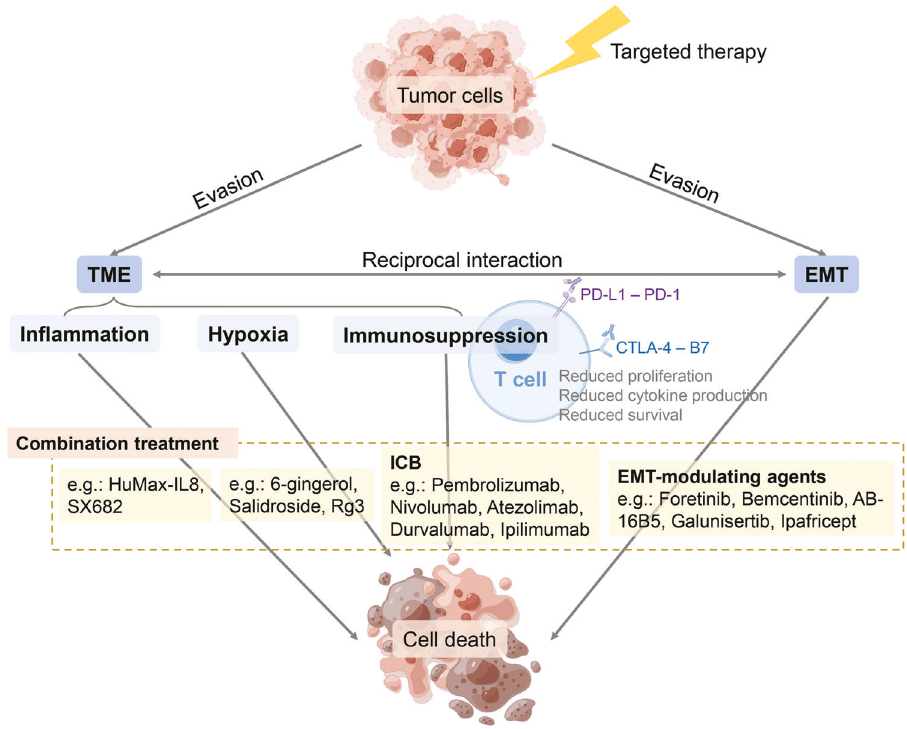
Fig. 5 Combination treatments for overcoming the tumor cell plasticity induced-therapy resistance. Tumor cells evade targeted treatments by interacting with TME and via EMT programs. In fl ammation, hypoxia, and immunosuppressive TME contribute to therapy evasion, and such induced-resistance could be inhibited by a combination treatment including anti-in fl ammation and anti-hypoxic drugs and immunosup- pressive ICB regimens. EMT-modulating agents, on the other hand, could also deal with plasticity induced-therapy resistance as a combination treatment and lead to tumor cell death. TME tumor microenvironment, EMT epithelial-to-mesenchymal transition, ICB immune checkpoint blockade, Rg3 ginseng-extracted